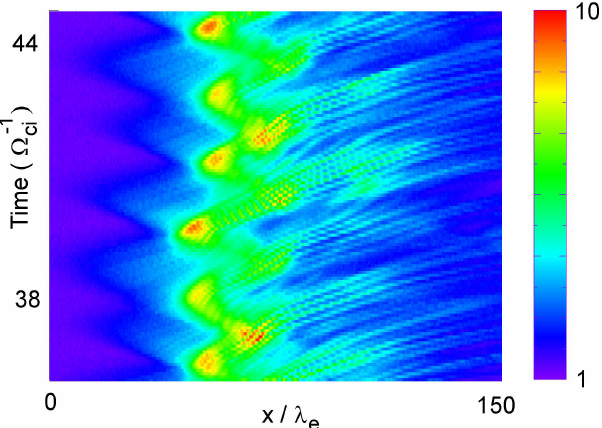
Fig. 9. Color coded magnetic field B z component in the t − x plane for the ion to electron mass ratio 100 run. The magnetic field has been shifted into an average frame standing with the shock.